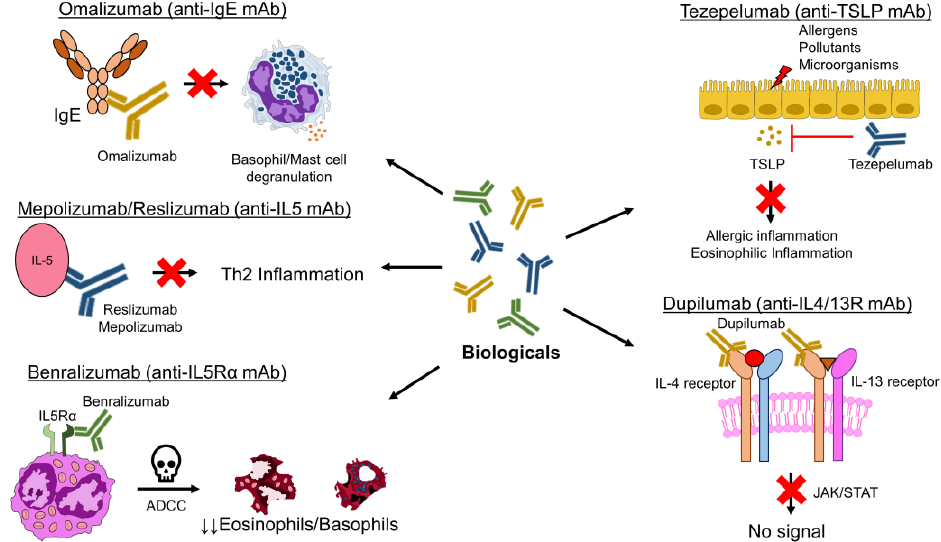
Figure 4. Biologicals used in asthma and AR. Mechanisms of action of different biologics are schematized (omalizumab, mepolizumab, reslizumab, benralizumab, tezepelumab, and dupilumab). Biologicals usually target inflammatory molecules, cytokines, or their receptors, blocking downstream inflammatory pathways or triggering-induced cell death. ADCC: antibody-dependent cell-mediated cytotoxicity; mAb: monoclonal